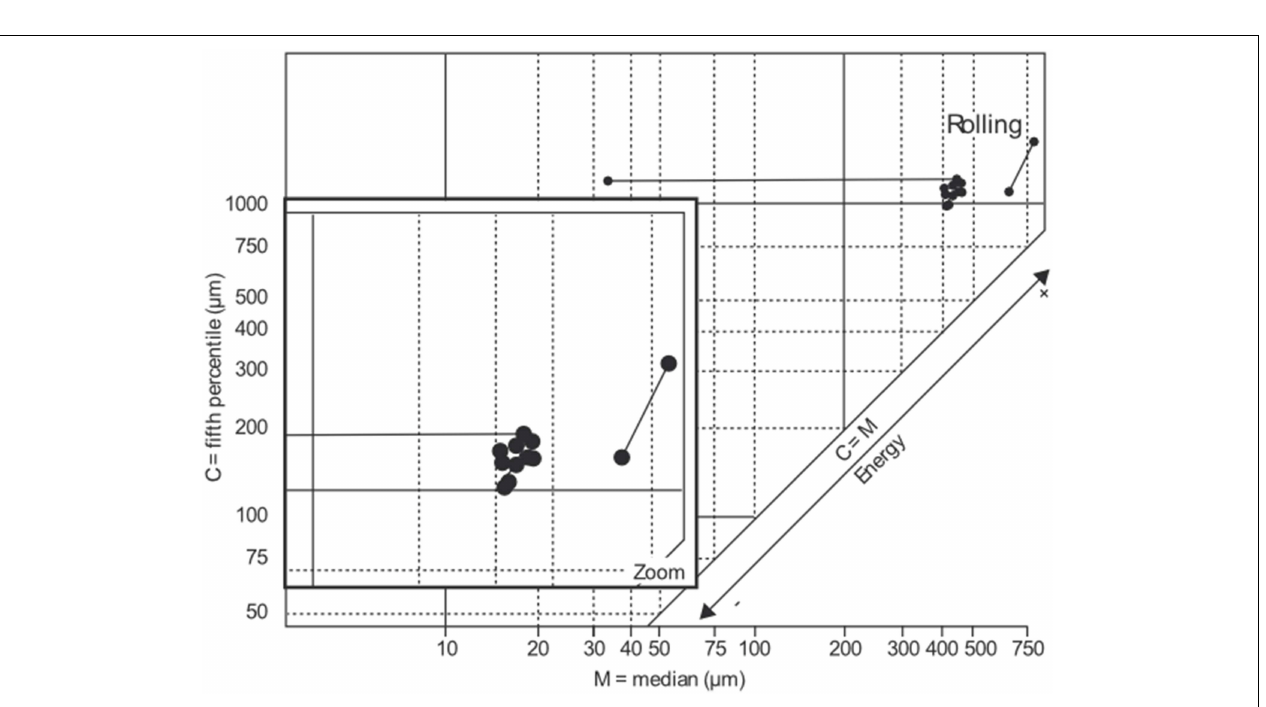
FIGURE 6 | Passega CM